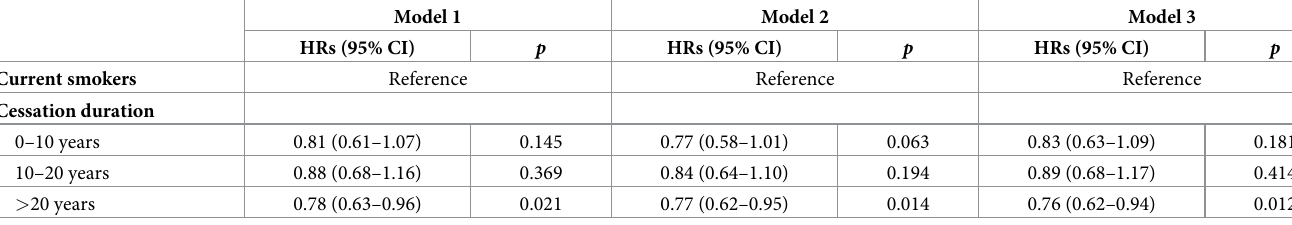
Table 4. Hazard ratios for incident CKD according to duration of smoking